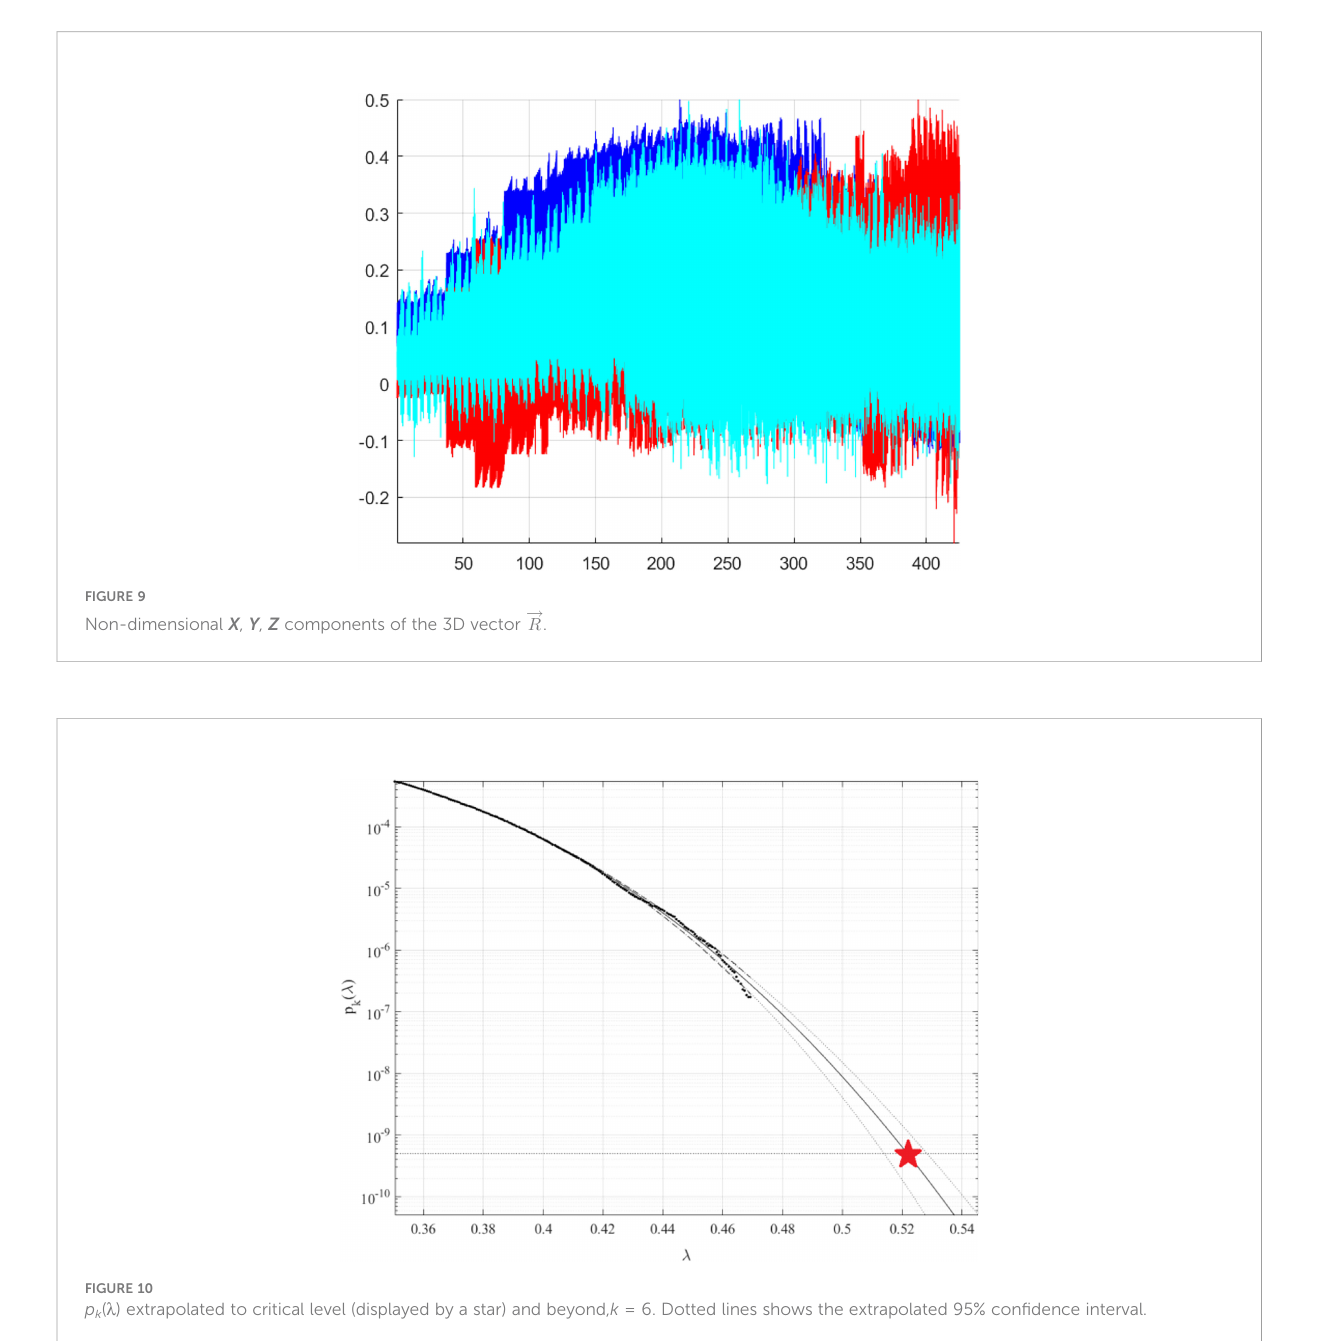
FIGURE 10 p k ( l ) extrapolated to critical level (displayed by a star) and beyond, k = 6. Dotted lines shows the extrapolated 95% con fi dence